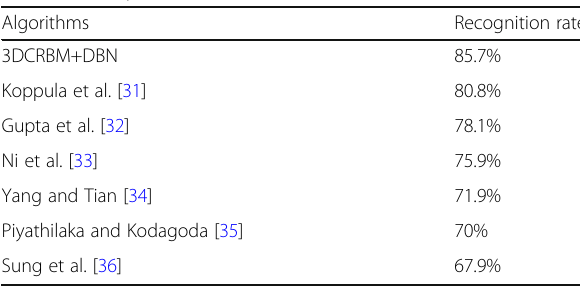
Table 1 Comparison of